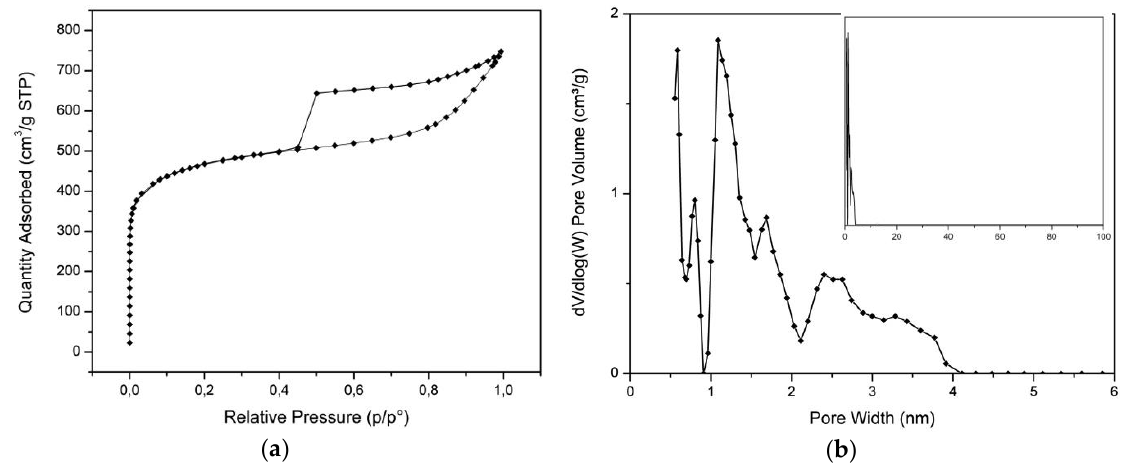
Figure 8. ( a ) Nitrogen sorption isotherms of the hydrochar microspheres, and ( b ) pore size distribution. The inset in ( b ) shows the distribution up to 100 nm.